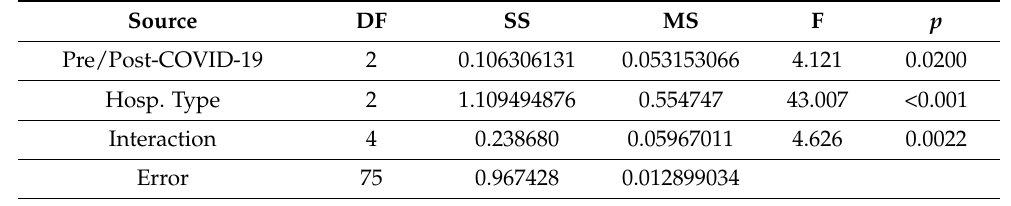
Figure 1. Percentage of patient seen within four hours in the emergency department (DTD) over 28 months in three hospitals (GEN, MCH, MDC). Table 2. Analysis of Variance (ANOVA).